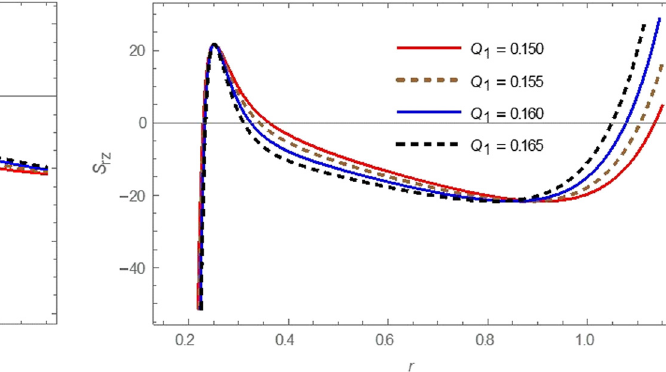
Figure 8: E ff ect of di ff erent values of ϵ on stress with W